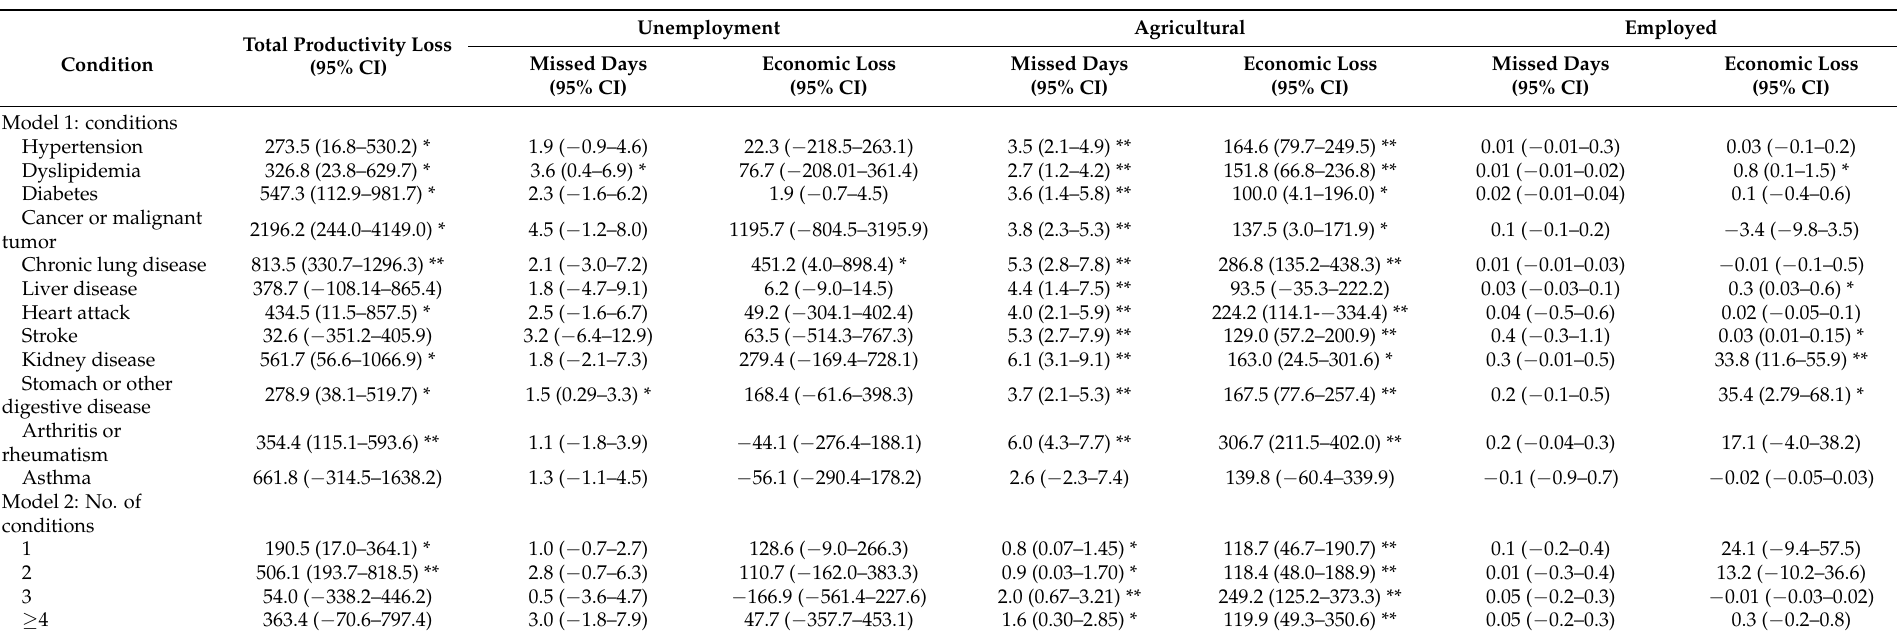
Table 3. Additional missed days and productivity loss among chronic patients with depressive symptoms compared with chronic patients without depressive